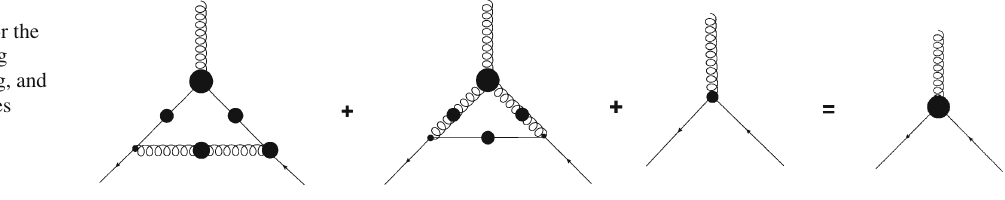
Fig. 5 One-loop dressed Bethe–Salpeter equation for the quark-gluon vertex. The big blobs represent the dressing, and small blobs are bare vertices